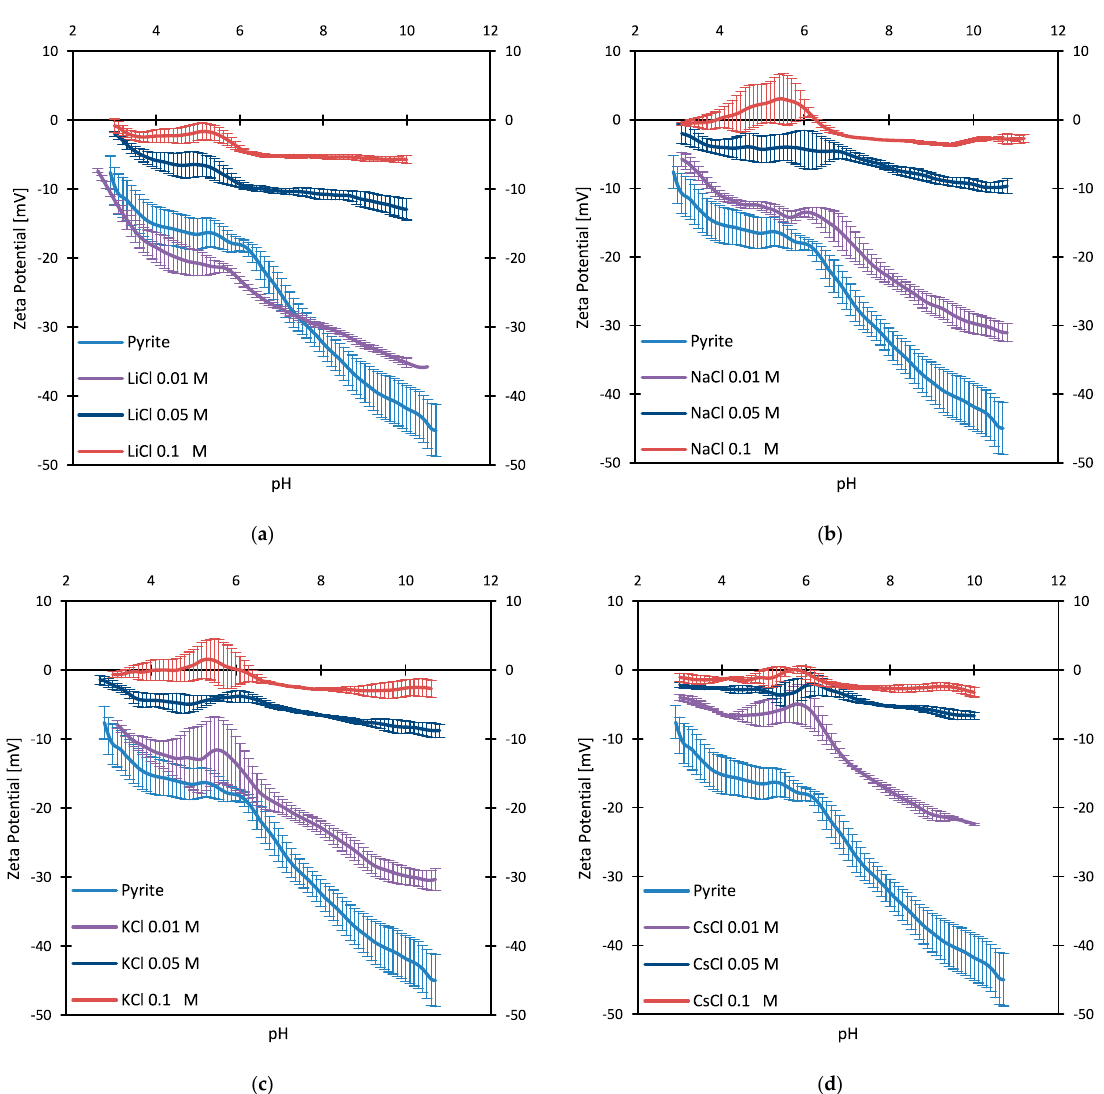
Figure 2. Zeta potential of pyrite as function of pH for different chloride salts of the monovalent alkaline metal series at increasing concentrations. ( a ) LiCl, ( b ) NaCl, ( c ) KCl, and ( d ) CsCl. Label Pyrite is omitted in curves for salts.